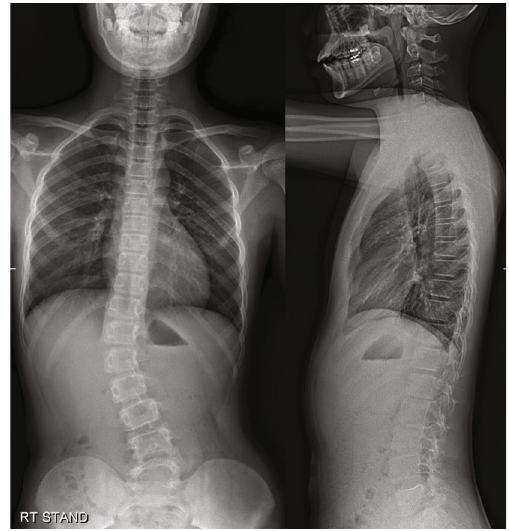
Figure 2: Whole spine plain radiograph. AP and lateral view when brace therapy was started, at June 16 th , 2014.